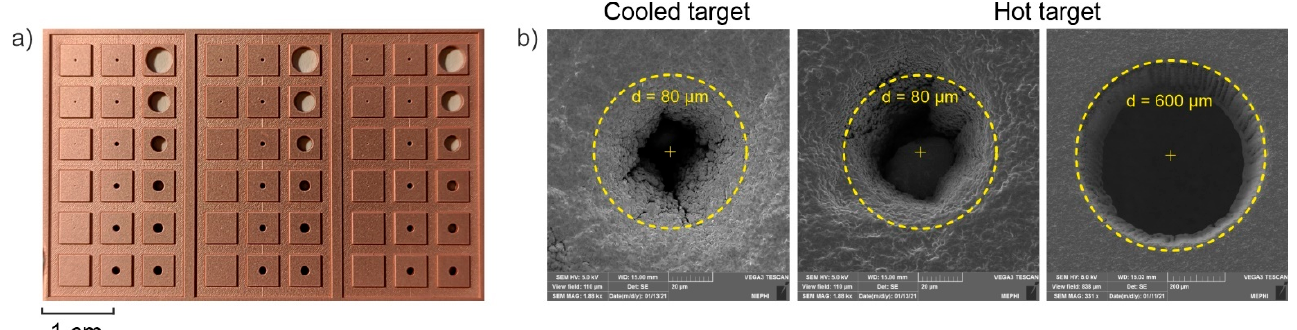
Figure 4. ( a ) Alumina substrate with laser-drilled through holes covered with copper film; ( b ) com- parison of SEM images of 80-µm diameter through hole with copper coating deposited by cooled ( b ) comparison of SEM images of 80- µ m diameter through hole with copper coating deposited and hot-target magnetron sputtering, and SEM image of 600-µm diameter through hole coated in by cooled and hot-target magnetron sputtering, and SEM image of 600- µ m diameter through hole hot-target magnetron mode. coated in hot-target magnetron